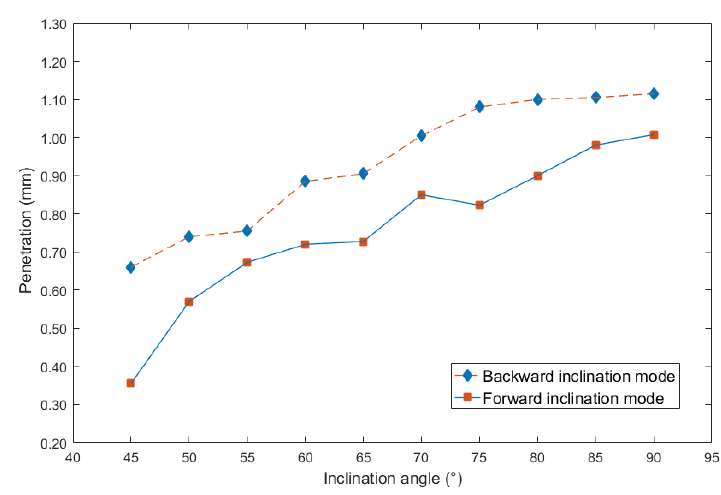
Figure 6. Curve between inclination angle and penetration.